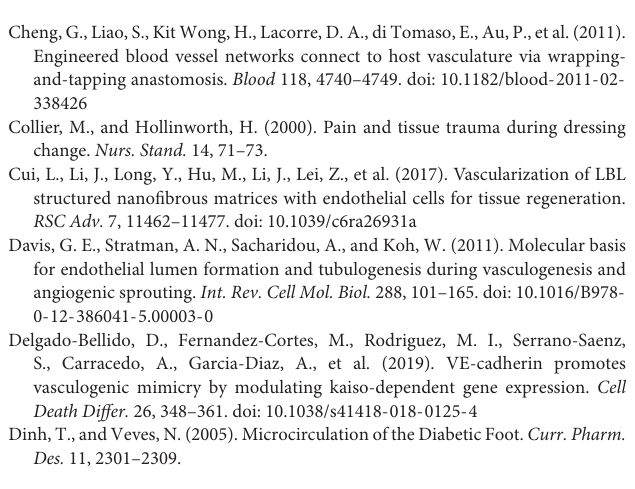
plastic ring. A nanofibre membrane was applied to the wound, and the hydrogel combined with the sensor was then placed on the wound. Supplementary Figure 6 | Three-dimensional image of lumen formed by HDMECs seeded on hydrogels. The three-dimensional lumen-like structures were formed in all groups, and the best morphology was in b and c group, which formed a vascular-like network. [Label descriptions: (a) pure GelMA, (b) with 2% β -cd, (c) with 3% β -cd, and (d) with 4% β -cd]. Supplementary Figure 7 | Application of hydrogels in chronic wounds. (A) Images of the wound healing process of diabetic rats. The healing speed of normal or hydrogel-treated wounds was significantly faster than that of diabetic rat wounds, and the hydrogel-treated group was even the fastest. (B) Immunohistochemical images of the wounds of diabetic rats (VWF). Only a small amount of abnormal angiogenesis could be seen in diabetic wounds. On the 7th day, a network of new small blood vessels was formed on normal wounds. The rate of new blood vessels forming was faster and the morphology was better after the application of hydrogel. (Label descriptions: (a) diabetic wound, (b) normal wound, and (c) diabetic wound treated with the hydrogel). Supplementary Table 1 | pH value of hydrogels before and after gelation with different β -cd amount